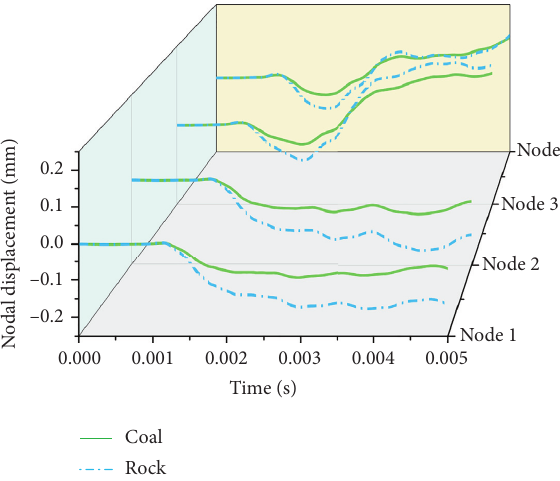
Figure 11: Nodal displacement in the tail beam noncollision contact zone under the impact of coal-rock